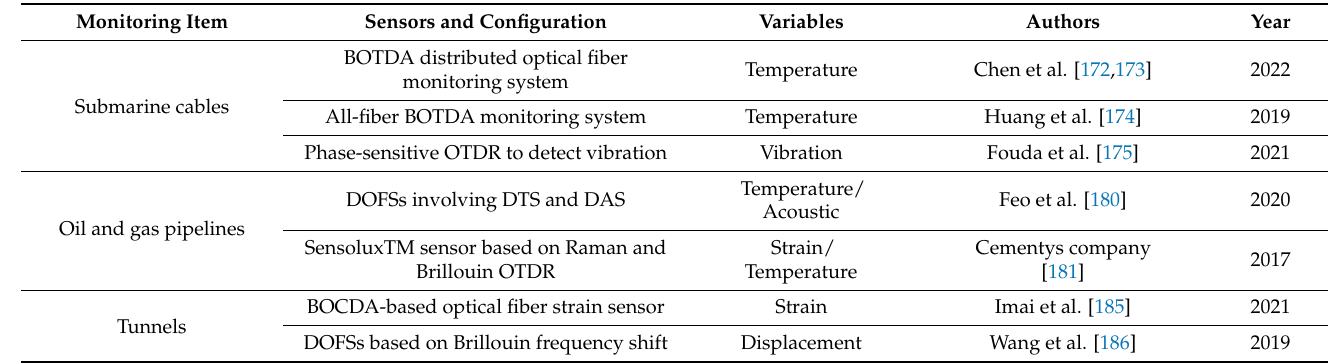
Table 3. DOFSs for Table 3. DOFSs for SHM.